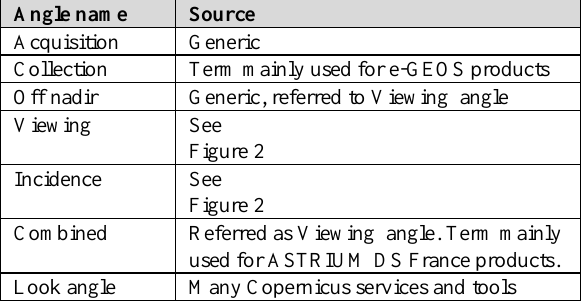
Table 4. Definitions of acquisition angles from various